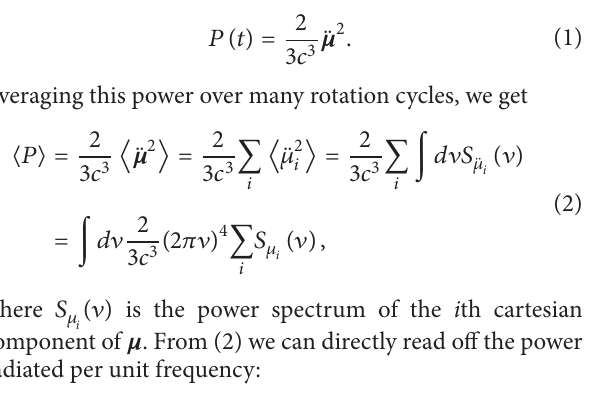
F 1: Euler angles used for the description of an axisymmetric grain. e �gure was reproduced from